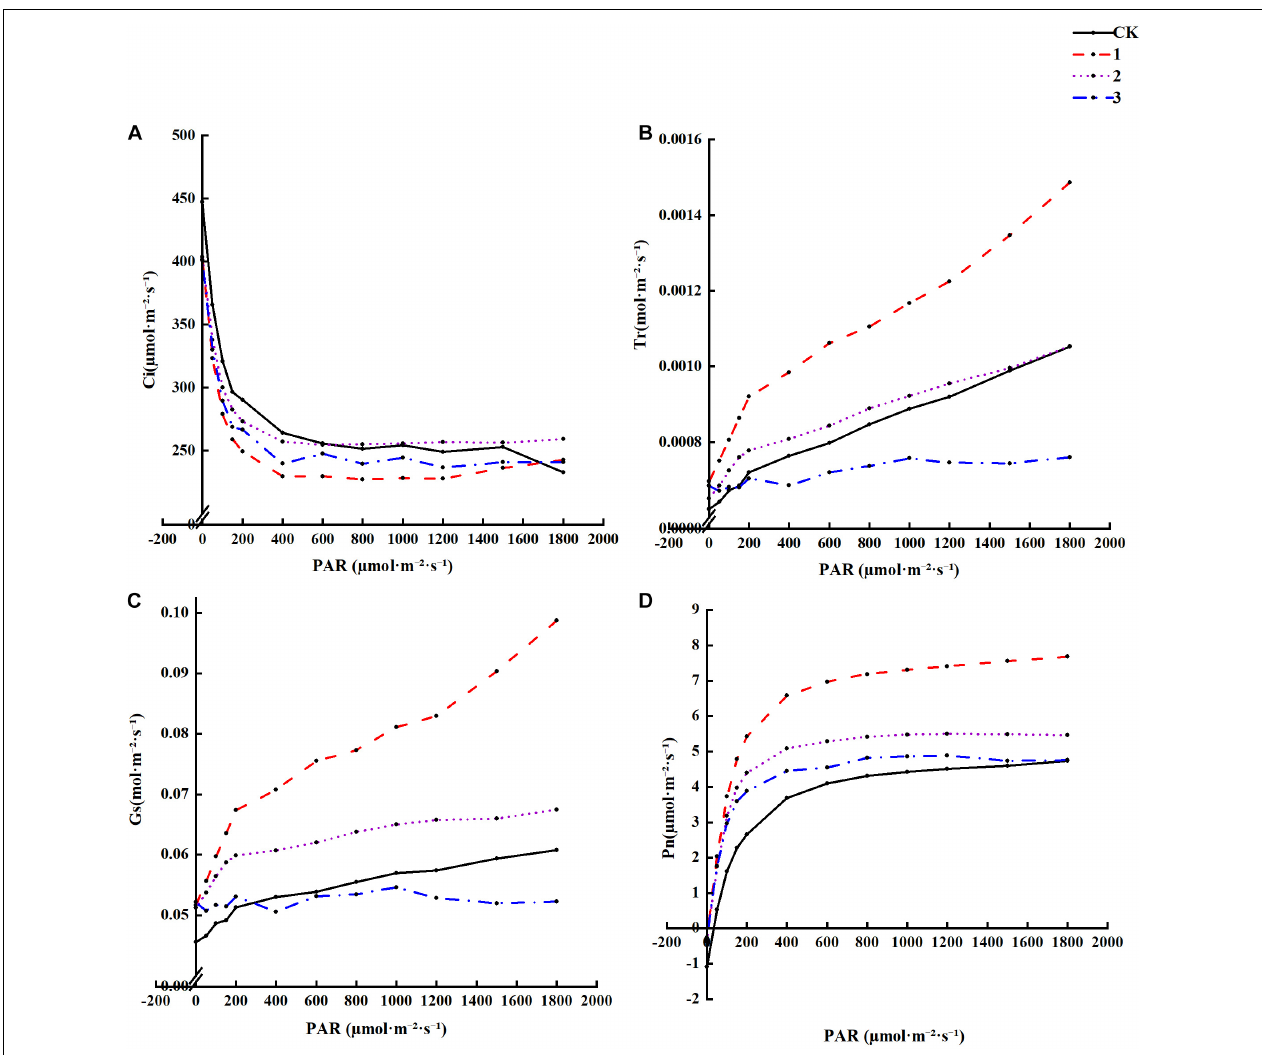
FIGURE 3 | The effect of different treatments on the Photosynthetic characteristics Horsfieldia hainanmensis (A–D) , respectively, represent the Ci (Intercellular CO 2 concentration), Tr (Transpiration rate), Gs (Stomatal Conductance), and Pn (Net Photosynthetic rate) of the influence of different light transmittance to Horsfieldia hainanmensis the light response